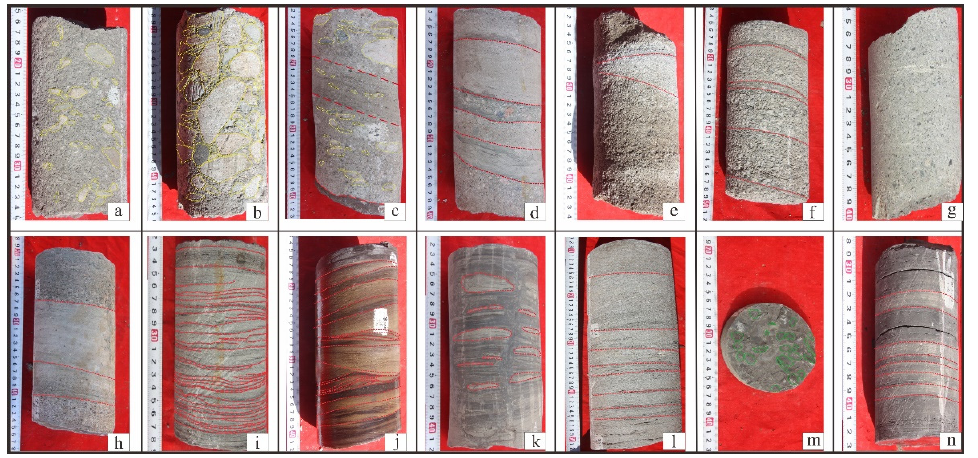
Figure 4. Lithofacies types of Saidong sub-sag in Saihantala sag, Erlian Basin. ( a ) Structureless